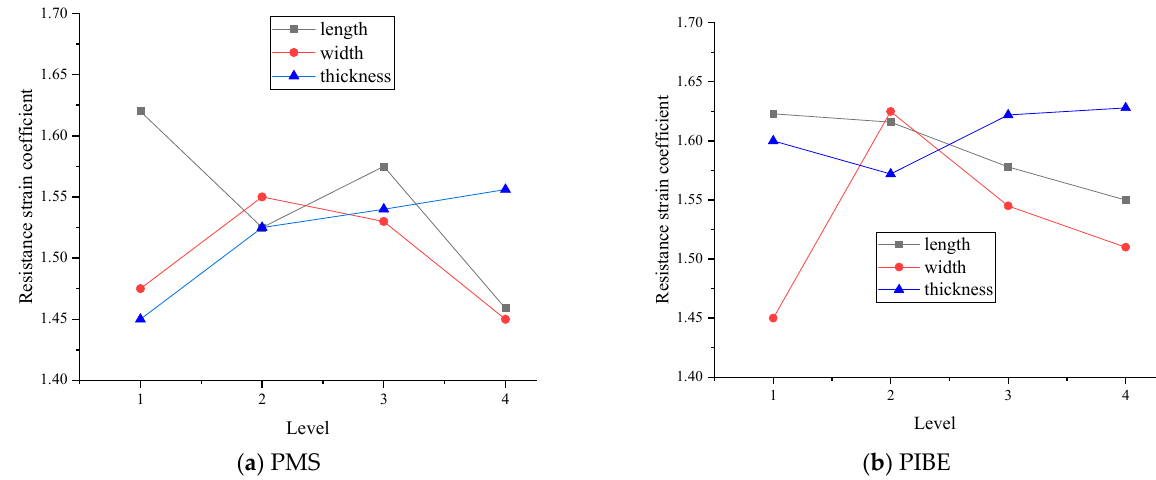
Figure 9. Analysis of resistance strain coefficients of thin-film resistor grid geometry. As Figure 9 shows, the resistance strain coefficient of the width of the longitudinal grid obtained by the two methods first increases and then decreases, and the corresponding resistance strain coefficient value is the largest when the width is 0.1 mm. The resistance strain coefficient increases as the thickness of the grid prepared by PMS increases, and the resistance strain coefficient first decreases and then increases as the thickness of the grid obtained by PIBE increases. The resistance strain coefficient first decreases and then increases when the length of the resistance grid prepared by PMS increases, and the resistance strain coefficient decreases when the thickness of the resistance grid obtained by PIBE increases. The thickness of the longitudinal grid has the least effect on the resistance strain coefficient. According to the above analysis, it can be seen that a better resistance strain coefficient can be obtained by PIBE. For the resistance grid, the cutting force is mainly measured in the length direction of the grids; the PIBE is used to obtain the resistance grid in this paper.